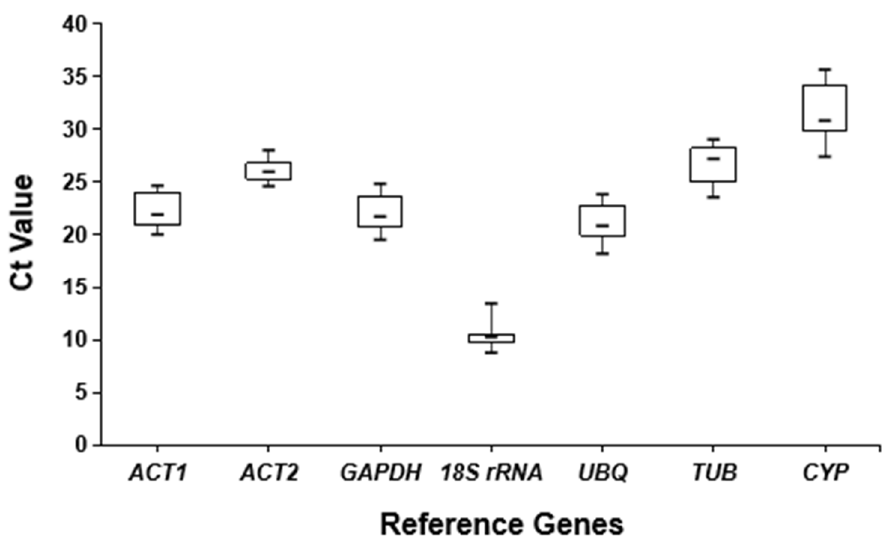
Figure 1. Ct values for seven candidate reference genes in all test samples: fruits of Actinidia latifolia , ‘Qinmei’, ‘Hayward’, ‘Hort16A’, ‘Jinshi 1’, ‘Hongyang’ and ‘Hongshi 2’ at 30 days after 75% flower